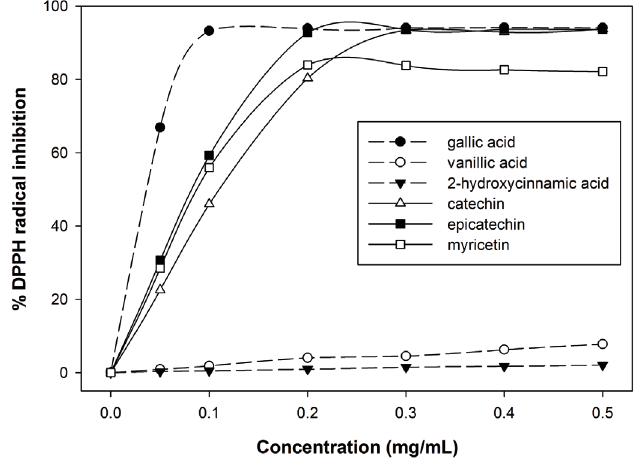
Fig. 5: DPPH radical inhibition percentage of phenolic compounds iden- tified in pineapple cv. Esmeralda.